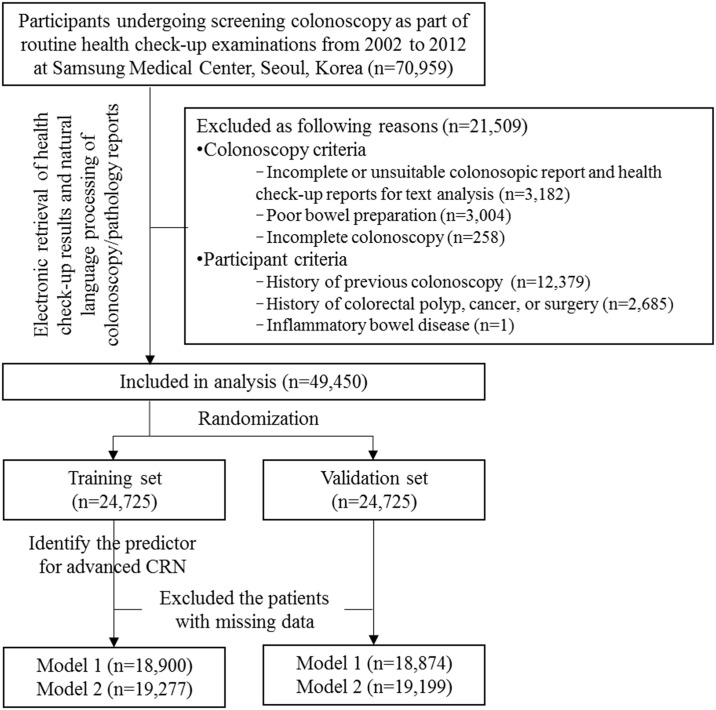
Flow diagram of the study population.